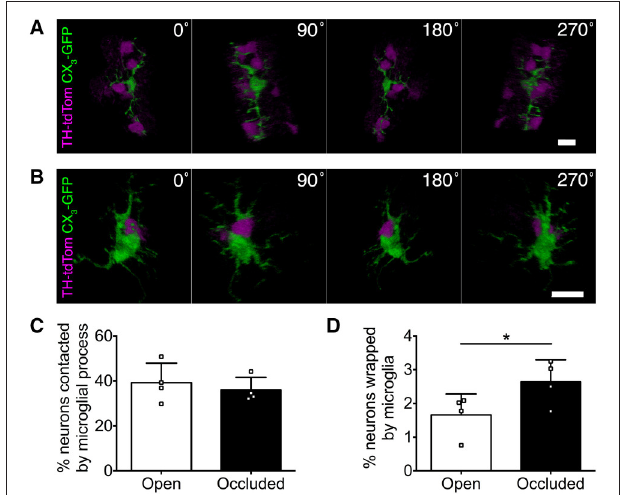
FIGURE 6 | Microglial-neuronal interactions are activity-dependent. (A,B) 3D reconstructions showing microglia (A) contacting multiple DA neurons or (B) wrapping a DA neuron. (C) Similar percentage of DA neurons contacted by microglia in occluded and open OBs ( p = 0.22, t = 1.56, paired t -test). (D) Greater microglial wrapping of DA neurons in occluded OBs ( * p = 0.017, t = 4.78, paired t -test). (C,D) : n = 4 pooled pairs of control OBs from 4 control mice and 4 pairs of open and occluded OBs from 4 naris-occluded mice.